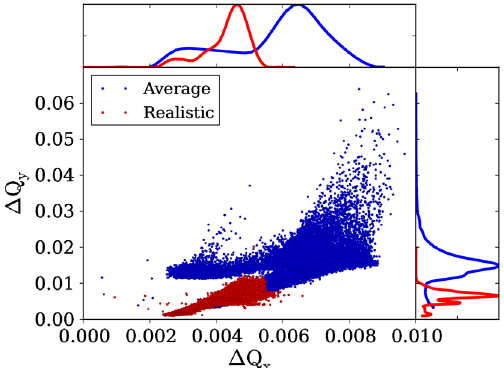
FIG. 9. Tune spreads for the LHC-type bunch in round geometry with magnetic field B ¼ 0 . 1 T . Uniform cloud density is equal to the average realistic cloud density. Bunch population